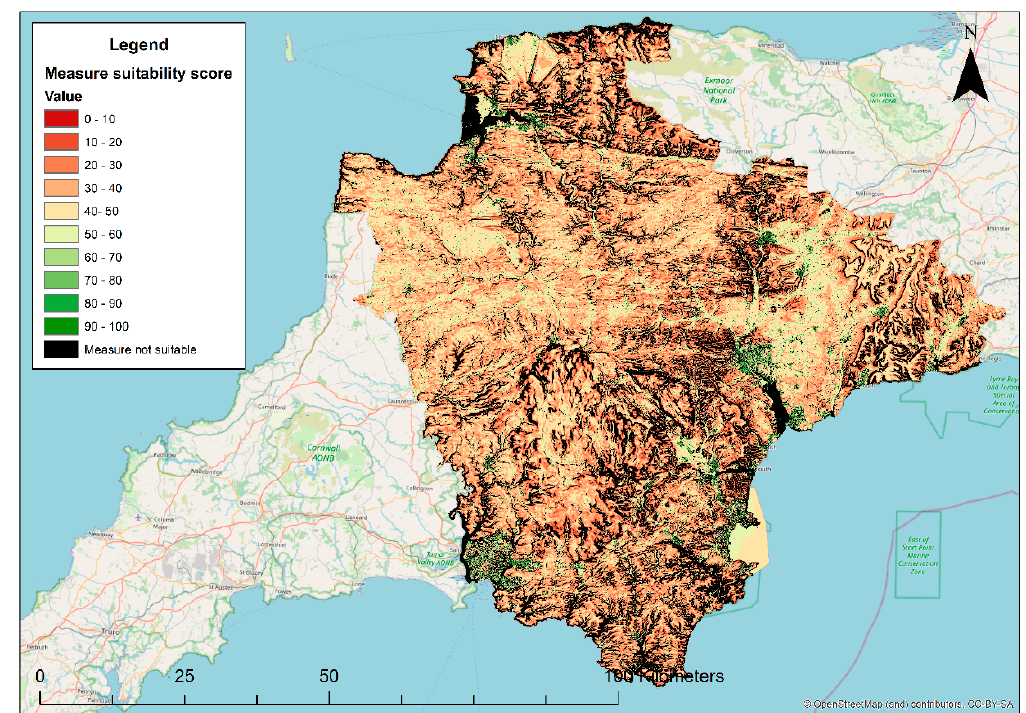
Figure 4. Opportunity map showing potential locations for bioretention and rain gardens in Devon.